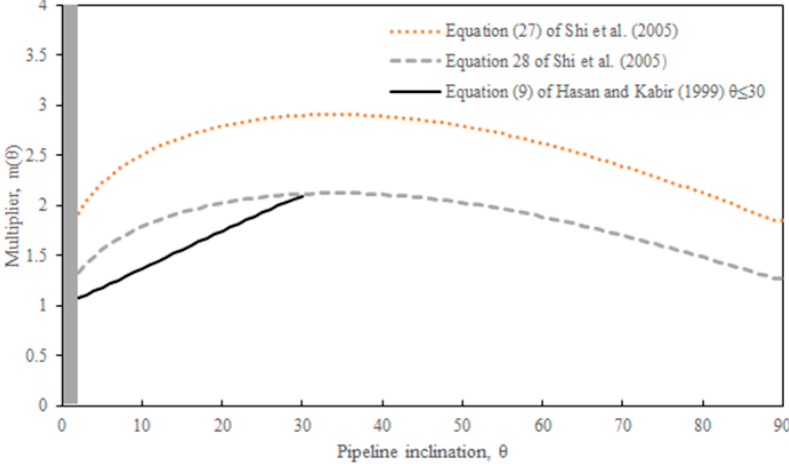
Figure 3. Three forms of the expression for inclination multiplier m( θ ). This figure was modified from ref [60,77,83]. Table 1. Summary of datasets from TUFFP used for parameters optimization in Tang et al.’s